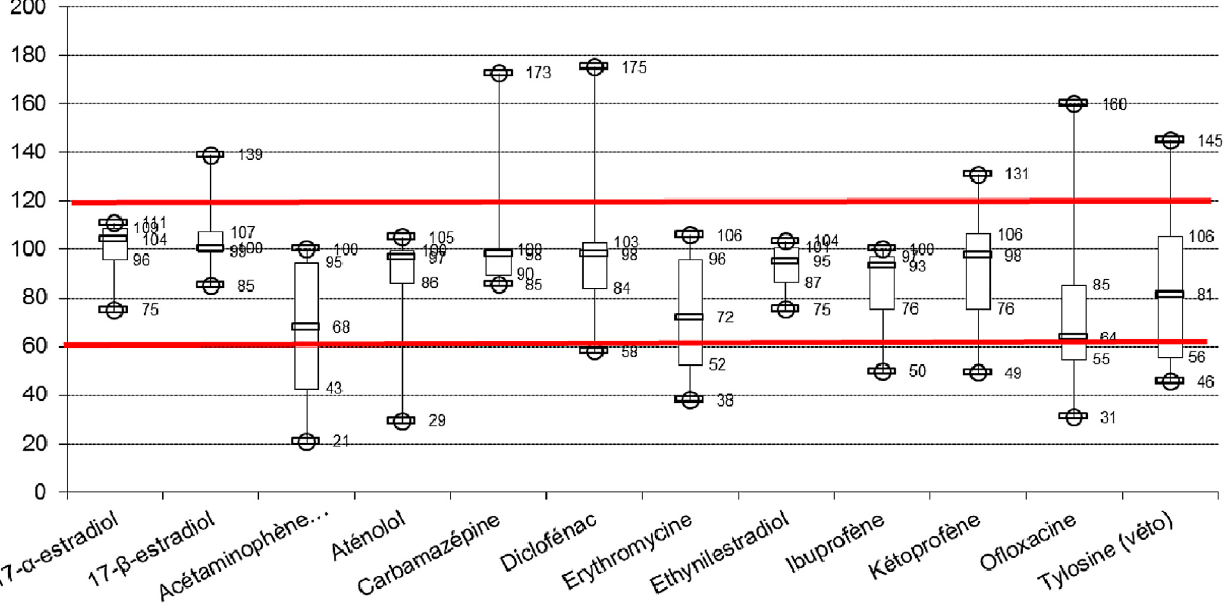
Fig. 2. Graphic illustration of yields according to the Tuckey diagram.